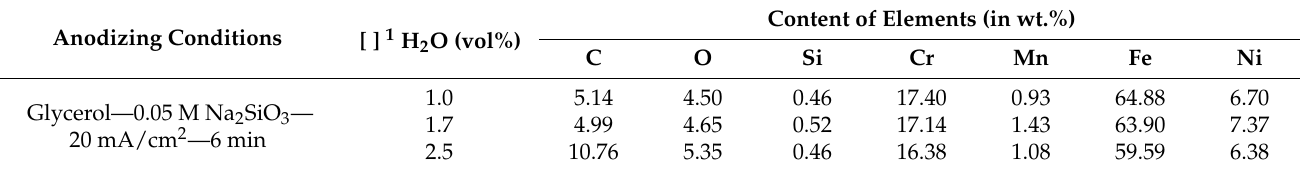
Figure 8. SEM images of the anodic layers grown in a glycerol, 0.05 M Na 2 SiO 3 with H 2 O concentra- tion of ( a , b ) 1.0, ( c , d ) 1.7, and ( e , f ) 2.5 vol% for 6 min at 20 mA/cm 2 . Table 2. EDS analysis of the 304L SS anodic layers from Figure 8. Table 2. EDS analysis of the 304L SS anodic layers from Figure 8.